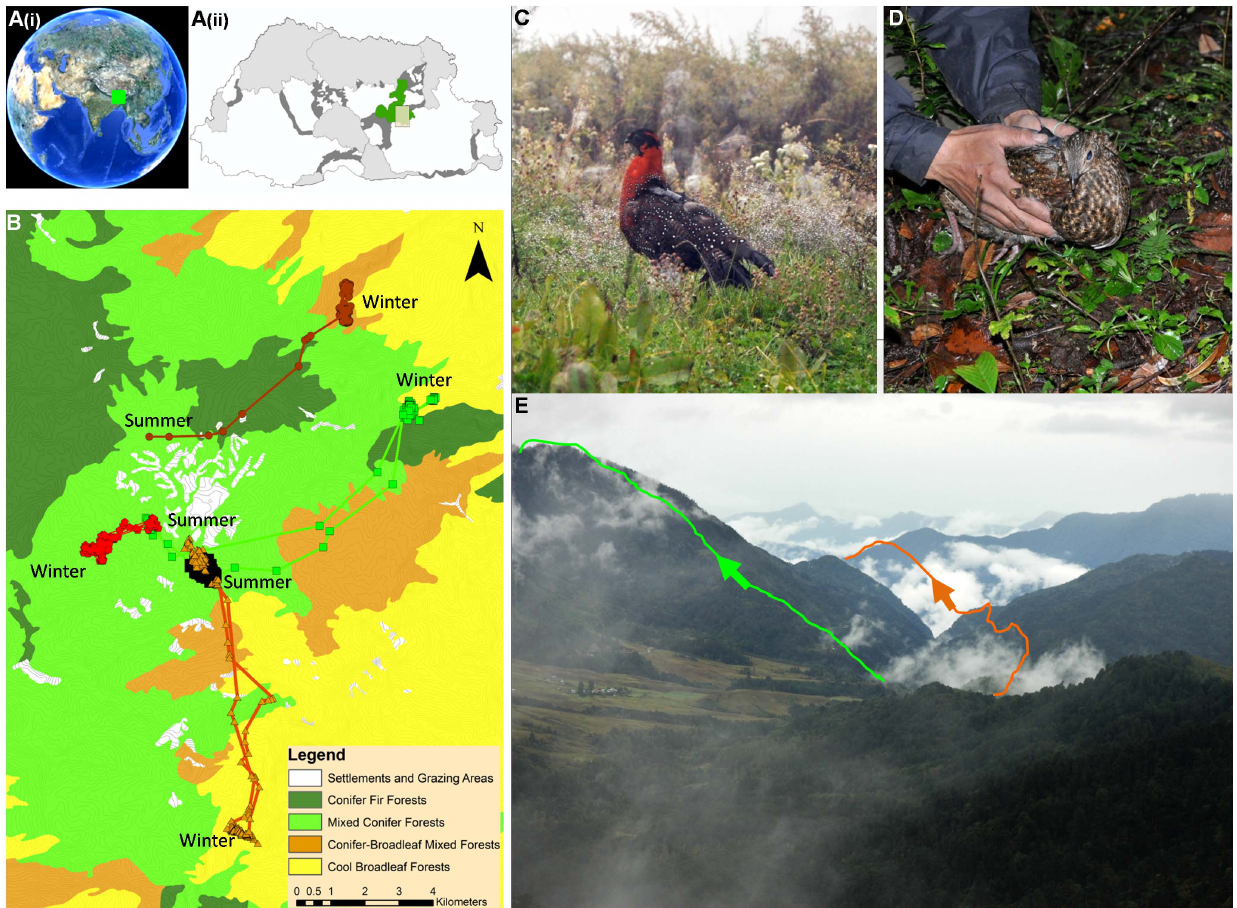
Figure 6. Location of Bhutan (A[i]) and Thrumshingla National Park in Bhutan shown in green (A[ii]). Location of study area bounded by rectangular box (A[ii]). Light grey areas show protected areas in Bhutan and dark grey areas show biological corridors. Land cover, locations for 1 resident (black circles) and migratory routes for 4 migratory individuals (3 females and 1 male [green squares and line] within the study area (B)). A tagged male (C) and a tagged female (D) being released. Travel route of a male migrant shown in green and female migrant shown in yellow (B) overlaid onto a photograph of the actual mountain location (E).